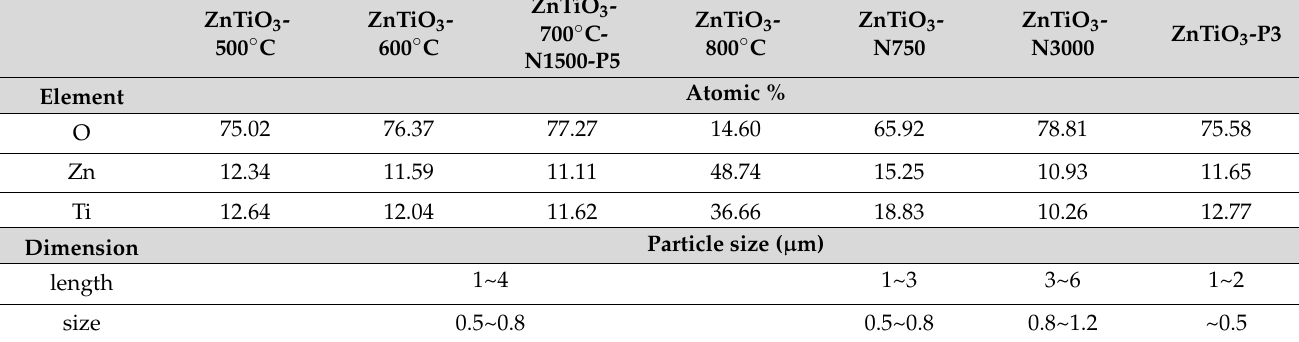
Table 1. The particle size and element analysis of ZnTiO 3 prepared in various